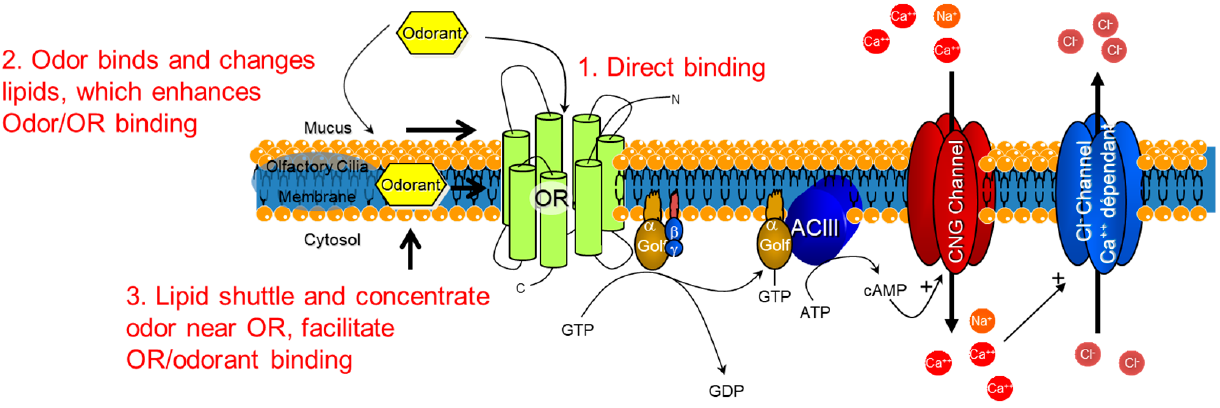
Figure 8. Possibilities for how the lipid bilayer membrane could assist in the molecular binding of odorants. Schematic depicting the odorant receptor (OR) G-protein-coupled receptor cascade and the three possibilities for molecular triggering of the cascade. 1. Direct binding of the odorant to the OR. 2. Lipid reorganization from odorants could provide access for the odorant to arrive in the binding site of the OR. 3. Lipids shuttle and concentrate odorants near the OR to facilitate OR/odorant binding. Golf = G-protein olfaction, ACIII = Adenyl cyclase 3, CNG = cyclic nucleotide.